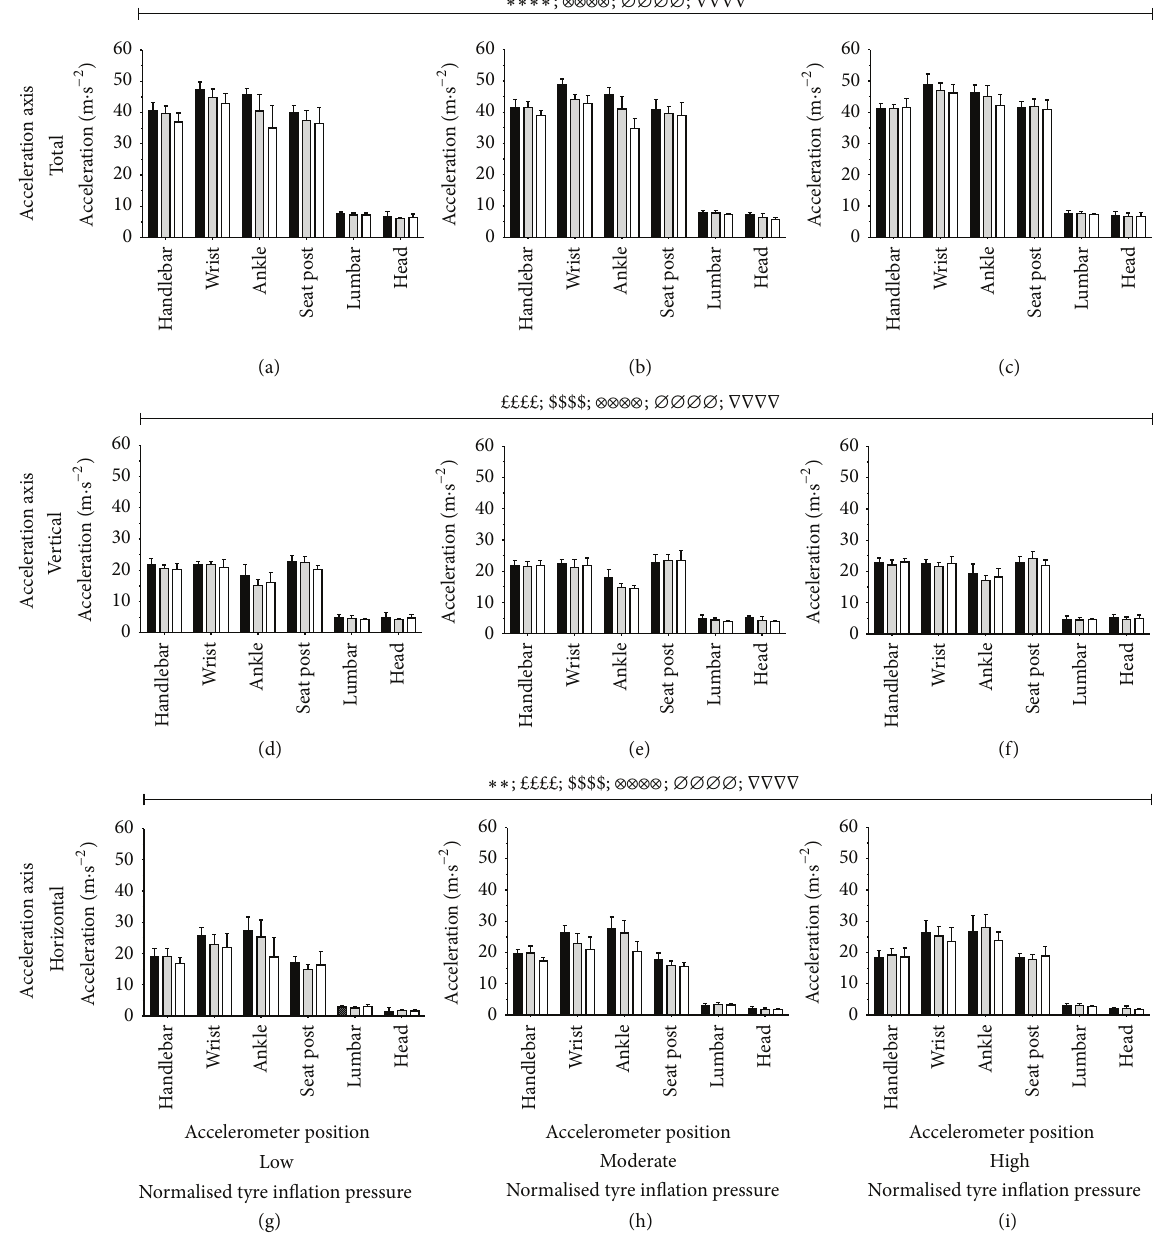
Figure 5: Comparison between tyres (CycloXKing (black bar), 2.2 XKing (gray bar), and 2.4 XKing (white bar)) and three normalised tyre inflation pressures characterised as low (1), normal (2), and high (3) for (a)–(c). Total accelerations: (d)–(f). Vertical accelerations; (g)– (i). Horizontal accelerations, where ∗ refers to the interaction for tyre size ∗ tyre pressure ( ∗∗∗∗ 𝑃 < 0.0001 ; ∗∗ 𝑃 < 0.01 ), $ refers to the interactionfortyresize ∗ accelerometerlocation ( $$$$ 𝑃 < 0.0001) , m referstotheinteractionfortyrepressure ∗ accelerometerlocation( mmmm 𝑃 < 0.0001 ); ⊗⊗⊗⊗ (𝑃 < 0.0001) maineffectoftyresize; ØØØØ (𝑃 < 0.0001) maineffectoftyrepressure; ∇∇∇∇ (𝑃 < 0.0001) maineffectofaccelerometer